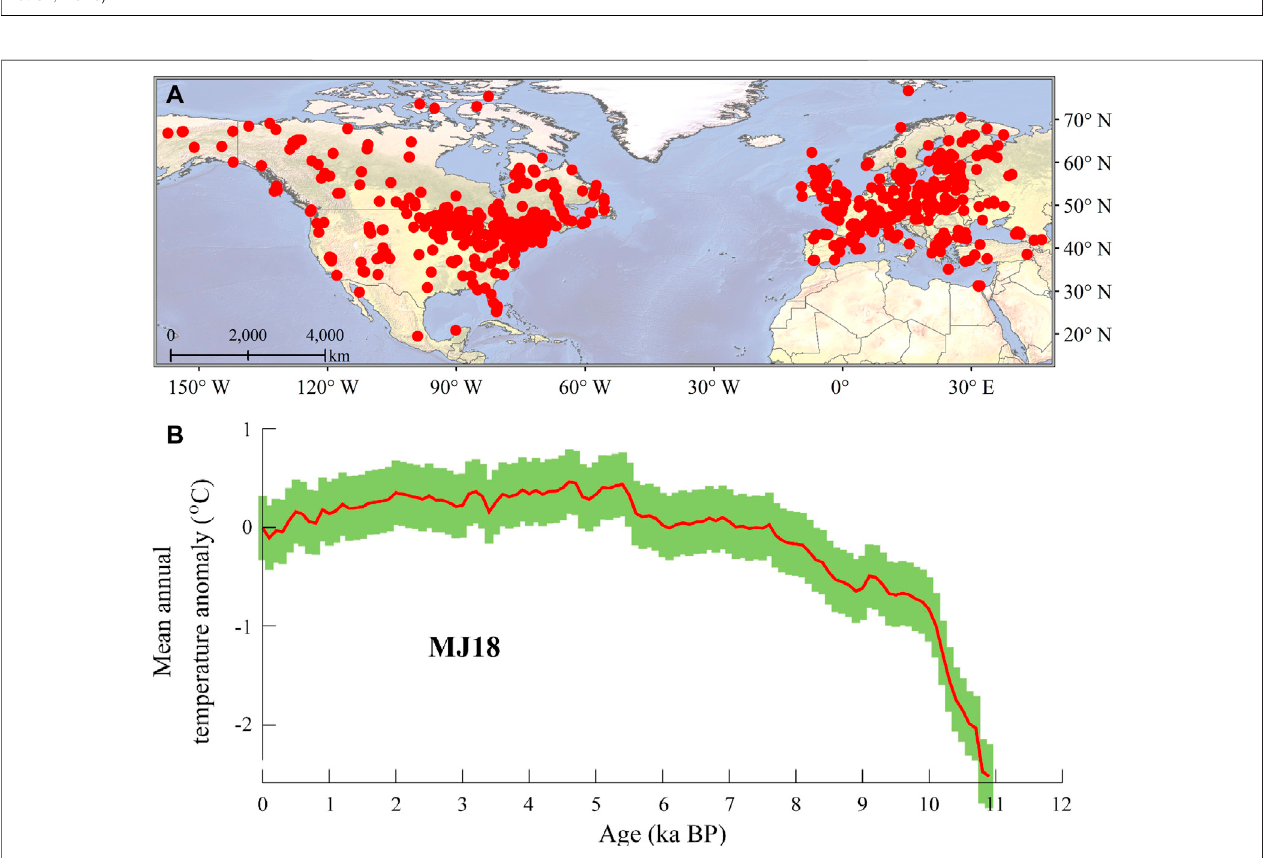
FIGURE 2 | Spatial distribution of pollen records in North America and Europe (A) and the corresponding regional stacked mean annual temperature record (B) ; Marsicek et al., 2018.